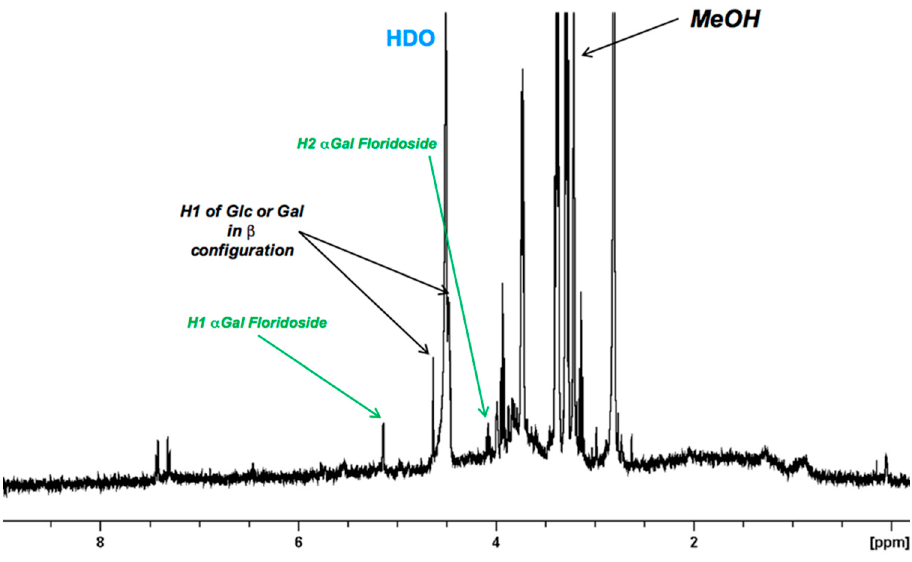
Figure 4. 1 H-NMR spectrum with floridoside annotations (in green).